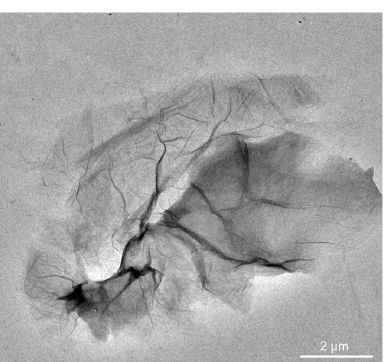
Figure A1. Transmission electron microscope (TEM) image of graphene oxide.